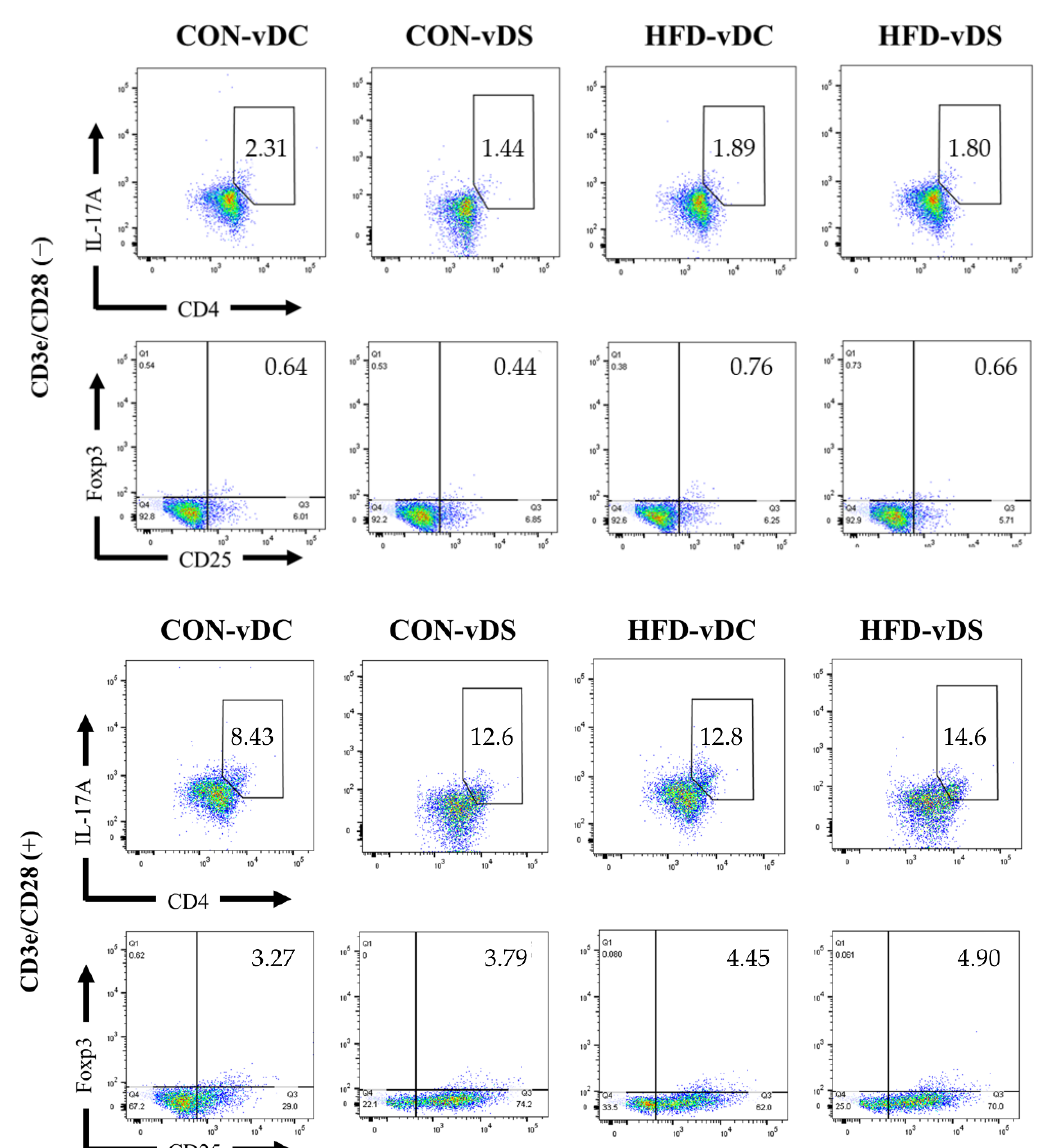
Figure 2. Populations of CD4 + IL-17 + T cells and CD4 + CD25 + Foxp3 + T cells (dot plots). The populations of CD4 + IL-17 + T cells and CD4 + CD25 + Foxp3 + T cells are presented as dot plots of the FlowJo analyses. CON-vDC, 10% kcal fat diet + vitamin D control; CON-vDS, 10% kcal fat diet + vitamin D supplemented; HFD-vDC, 45% kcal fat diet + vitamin D control; HFD-vDS, 45% kcal fat diet + vitamin D